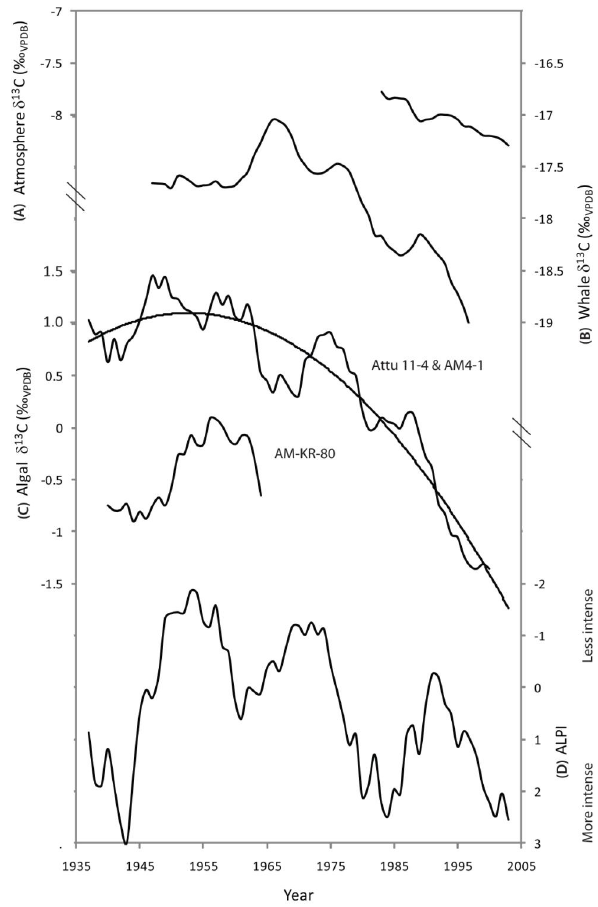
Fig. 5. (A) Annual atmospheric δ 13 C values from Pt. Barrow, Alaska (data from Keeling et al. (2001); http://scrippsco2.ucsd.edu/ data/flask co2 and isotopic/monthly iso/monthly ptb c13.csv), (B) the δ 13 C values from the baleen of bowhead whales (data from Schell et al. (2001)), (C) the δ 13 C values from algal speci- men AM-KR-80 and combined δ 13 C values from specimens Attu 11-4 (1937–1967) and AM4-1 and Attu 11-4 (1968–2003) with line of best fit calculated using SigmaPlot (Systat Software Inc., San Jose, CA), and (D) ALPI values (data from Beamish et al. (1997); http://www.pac.dfo-mpo.gc.ca/science/species-especes/ climatology-ie/cori-irco/indices/alpi.txt). Whale, algal and ALPI datasets were smoothed with a 7-year running mean. Algal and whale δ 13 C values decreased at a rate exceeding that expected due solely to the δ 13 C-Suess effect and likely reflects the combined in- fluence of the δ 13 C-Suess effect and an intensifying ALPI. Note that the y-axis for the ALPI is